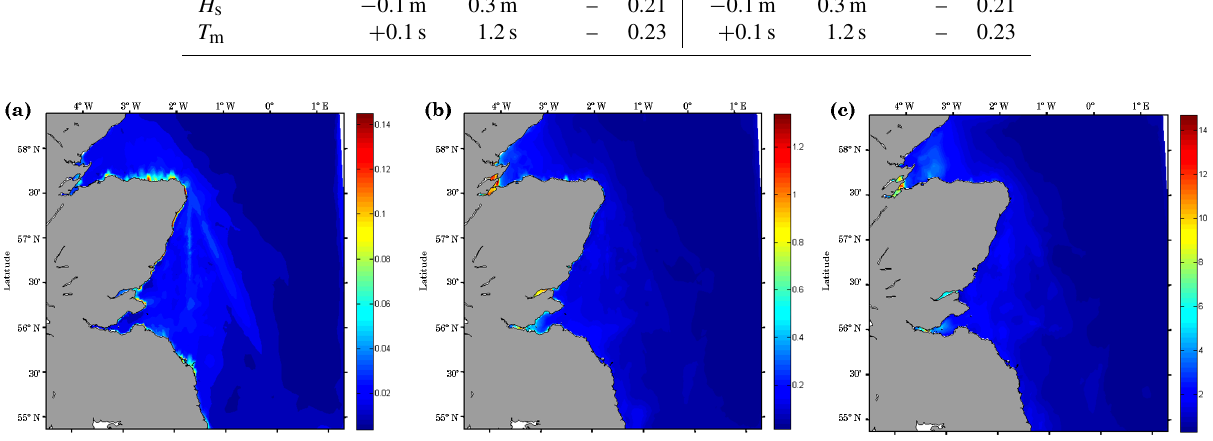
Figure 4. Root mean square difference between wave model output with and without WCI: (a) significant wave height (m), (b) peak wave period (s), (c) wave directional spreading